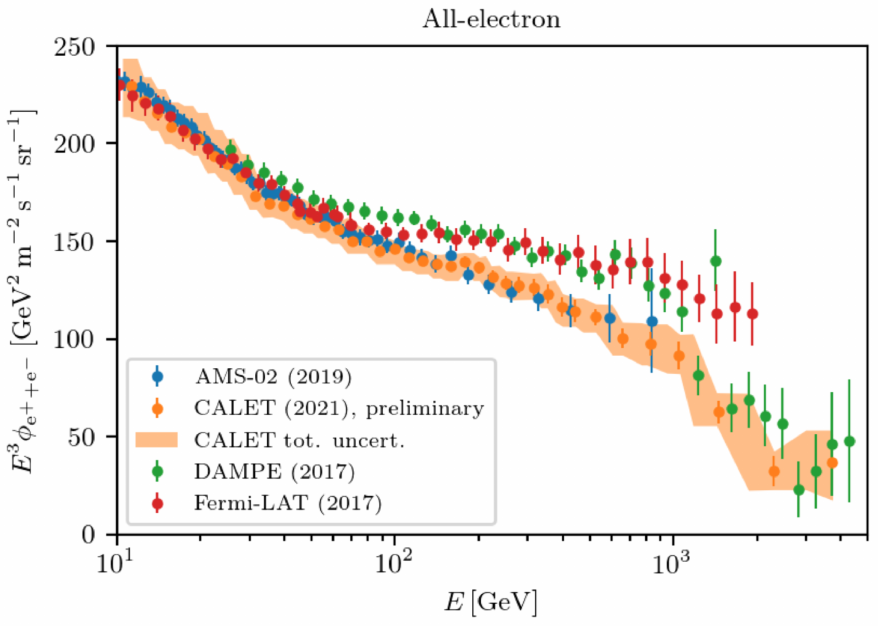
Figure 1. Recent direct measurements of the electron flux [7].